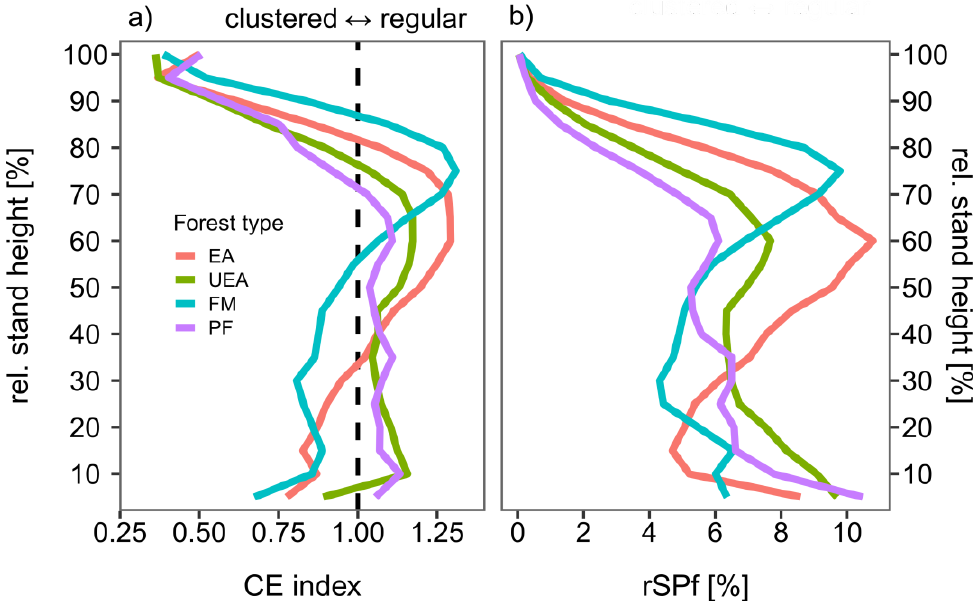
Figure 4. ( a ) Line plots showing the mean values of the Clark–Evans index (CE index) calculated for forest strata of 5% thickness each in the different forest types. Values > 1 indicate regular spatial patterns, while values < 1 tend to more clustered patterns. Values = 1 indicate random patterns; ( b ) Line plots showing the mean values of relative space filling (rSPf%) calculated for forest strata of 5% thickness each in the different forest types. Sample size per 5% height layer for different forest types was: even-aged (EA): n = 12, uneven-aged (UEA): n = 8, formerly managed (FM): n = 11, and primary forest (PF): n = 8.